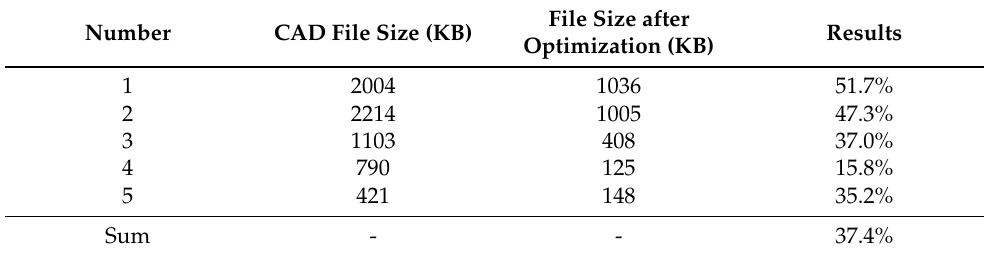
Table 5. CAD Design File Optimization (Reduction).